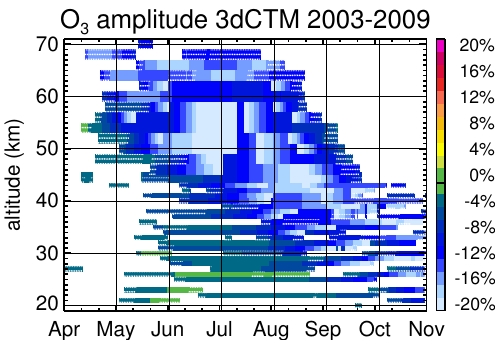
Figure 7. O 3 amplitude (see Sect. 2.4 for definition), simulated by the 3dCTM from 2003 to 2009. Shown are values above 95% sig- nificance level, according to a Student’s t test, and areas between 95 and 99% significance level are